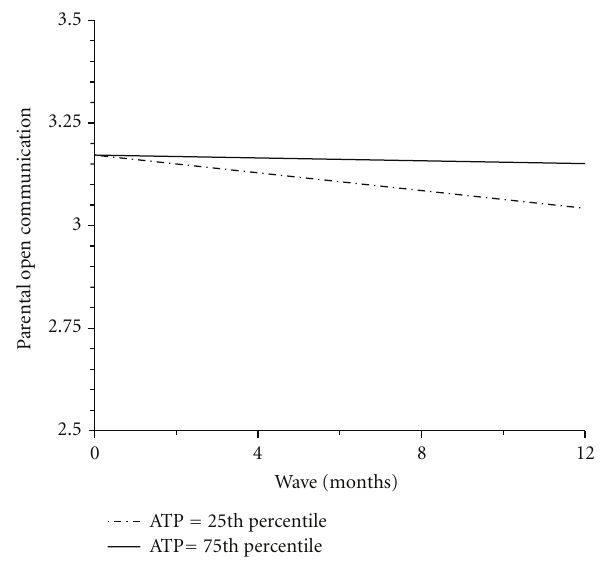
Figure 1: Parental open communication slopes at di ff erent levels of ATP. ATP: parent attitudes about monitoring and the importance of adolescent trust and privacy.